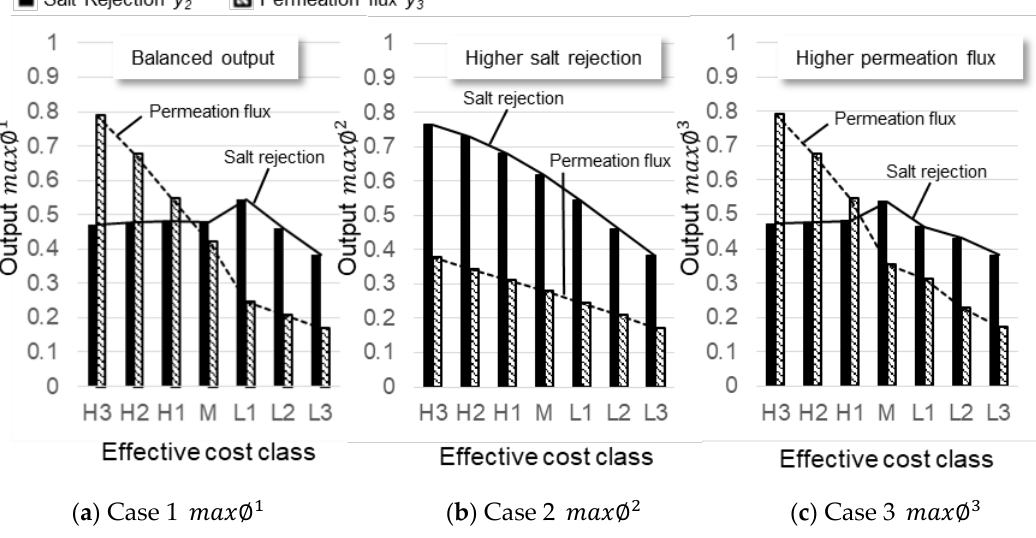
Figure 8. Output performances for the three cases.